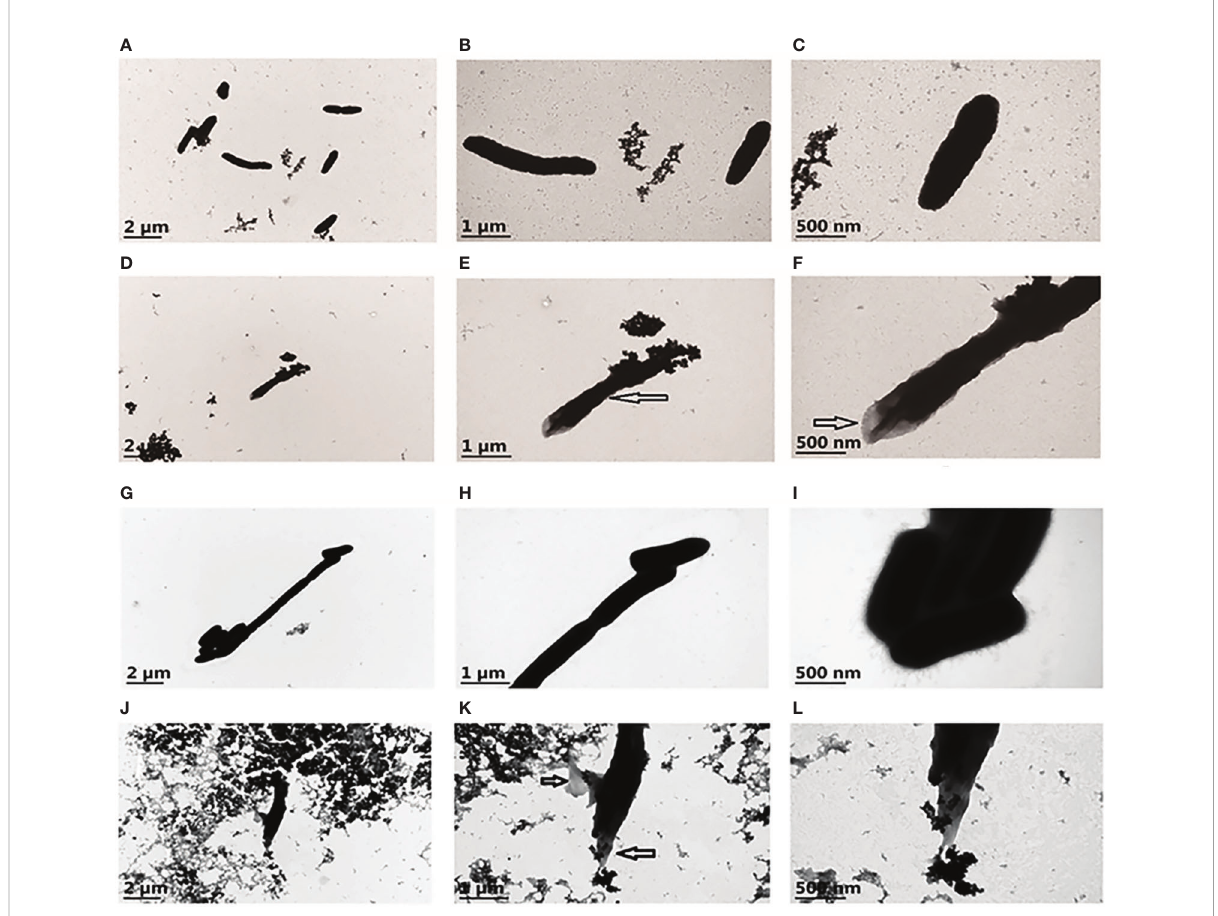
FIGURE 8 Transmission Electron Microscopy of V. parahaemolyticus and A . hydrophila untreated and treated with rPmlysG. (A) The control group of V. parahaemolyticus untreated with rPmlysG; (B, C) represent enlarged views of A; (D) V. parahaemolyticus action with rPmlysG; (E, F) represent enlarged views of D; (G) The control group of A. hydrophila untreated with rPmlysG; (H, I) represent enlarged views of G; (J) A. hydrophila action with rPmlysG; (K, L) represent enlarged views of